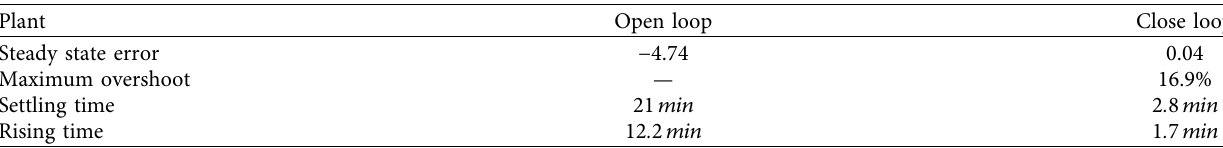
Figure 6: MPC block diagram [47].